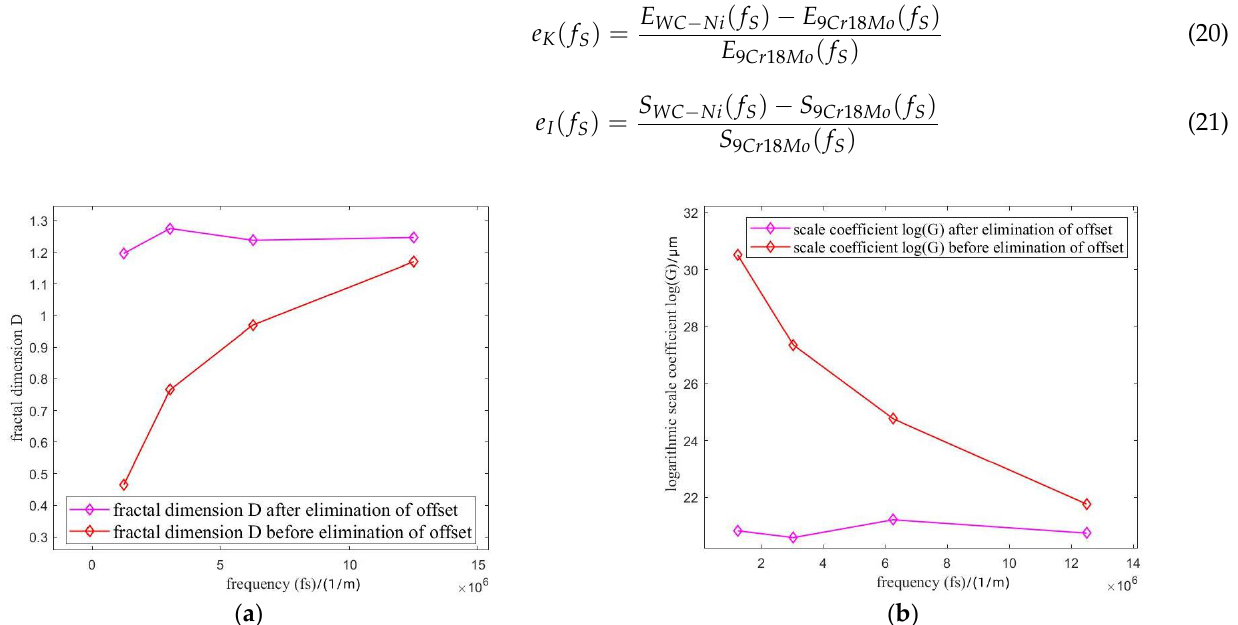
Figure 14. Comparison of fractal dimension D and scale coefficient G of fractal components before and after eliminating offset components. ( a ) D ; ( b ) G .